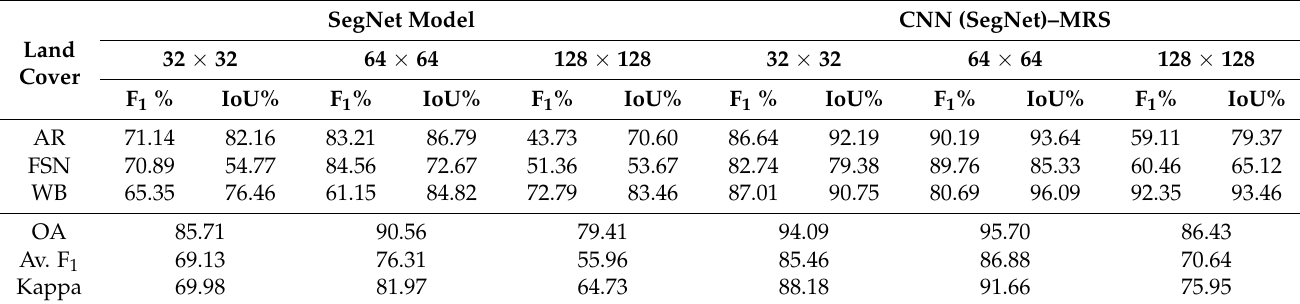
Table 7. Istanbul test site with 5 bands: performance metrics with SegNet.